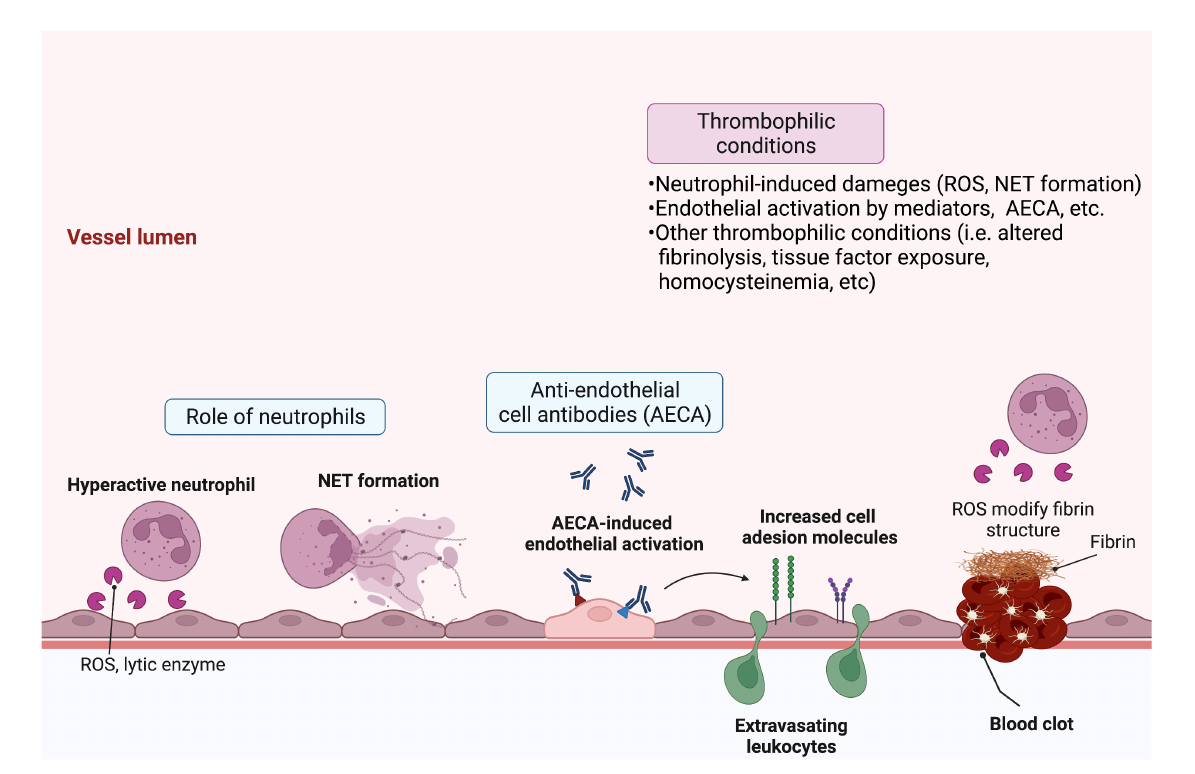
FIGURE1 Schematic overview of the pathologic features of Behçet’s disease (BD) that lead to vasculitis and thrombosis. Various factors contribute to endothelial damage and subsequent vasculitis and thrombosis in BD. Hyperactive infiltrating neutrophils release reactive oxygen species (ROS) and lytic enzymes and may form neutrophil extracellular traps (NETs), which activate or damage endothelial cells. Circulating anti-endothelial cell antibodies specific for various endothelial target proteins can further activate endothelial cells. In turn, they upregulate cell adhesion molecules that stimulate leukocyte migration. Moreover, activated endothelial cells can secrete proteins, including plasminogen activator inhibitor-1 (PAI-1) and tissue factor, which contribute to clotting and thrombosis. Patient characteristics, such as high levels of plasma homocysteine or neutrophil-derived ROS, can further augment thrombophilic activity via dysregulation of fibrinolysis. Created with